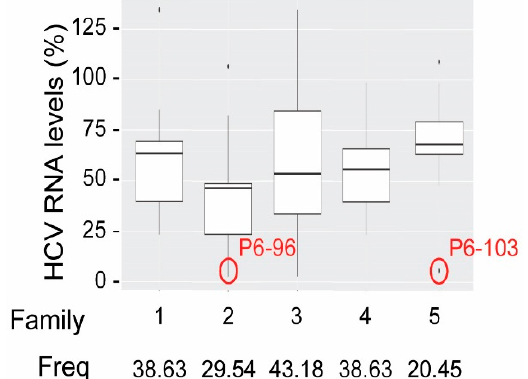
Figure 6. Inhibition of HCV replication in Huh-7 cells. Graph shows the HCV RNA levels in a hepatoma cell line supporting the autonomous cytoplasmic replication of a HCV subgenomic construct. Cells were transfected with the selected aptamers and HCV RNA levels were detected by RT-qPCR 24 h after transfection. Boxplot was generated with these data in order to group those aptamers with common sequence motifs, belonging to each of the identified families (1 to 5). The box reflects the 1st and 3rd quartiles, and the median is represented by a black line within the box for each aptamer family. Freq, refers to the prevalence of each family within the aptamer population.